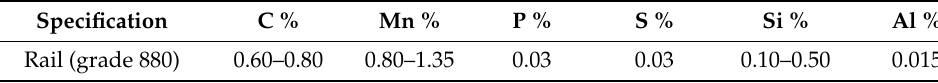
Table 2. Mechanical properties of wheel [33].